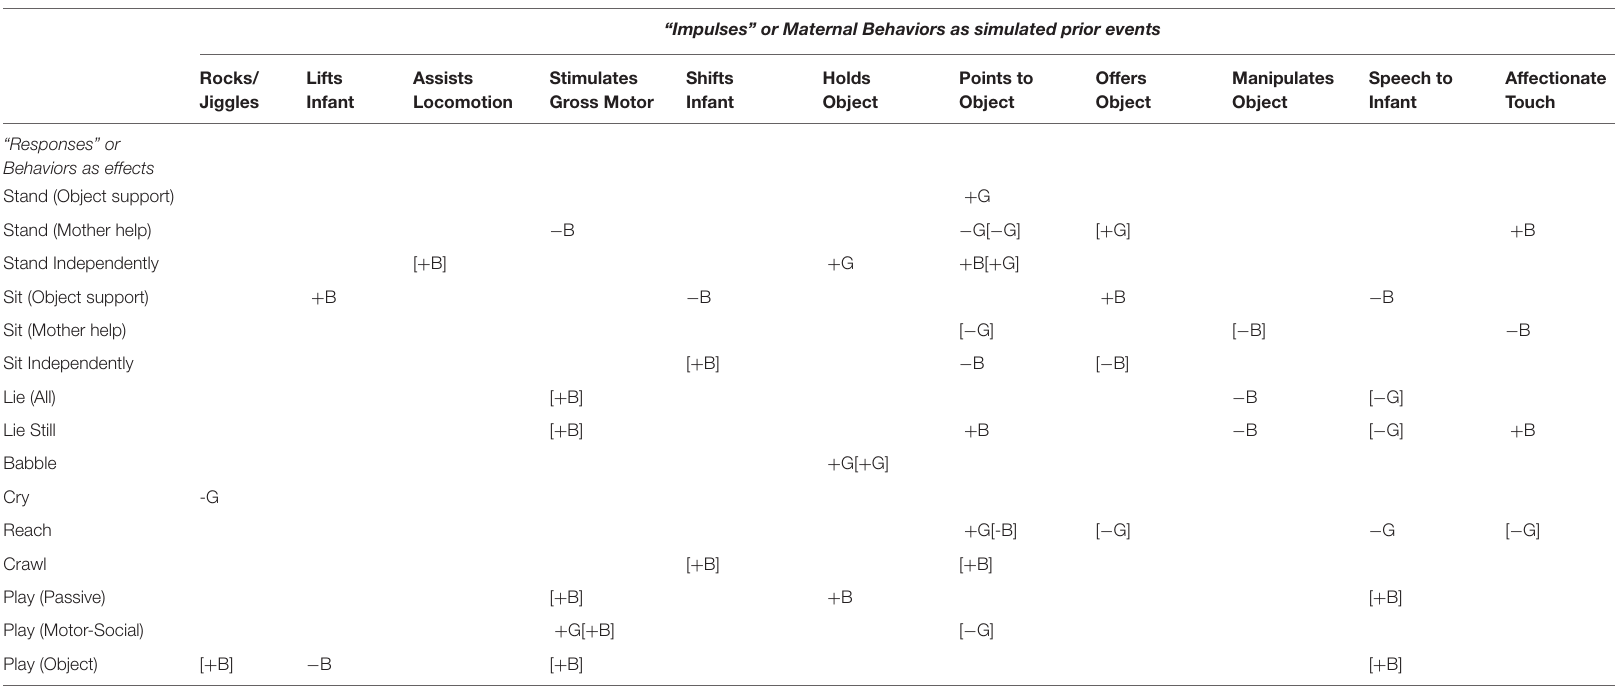
TABLE 2 | Matrix indicating presence/absence (B or G/blank) and direction of change ( + or − ) in boy or girl infant (B or G) behaviors (rows) in response to increases of maternal behaviors (columns) 1 to 3 months beforehand: Relationships between durations in seconds appear outside of brackets; relationships between numbers of occurrences appear inside brackets.